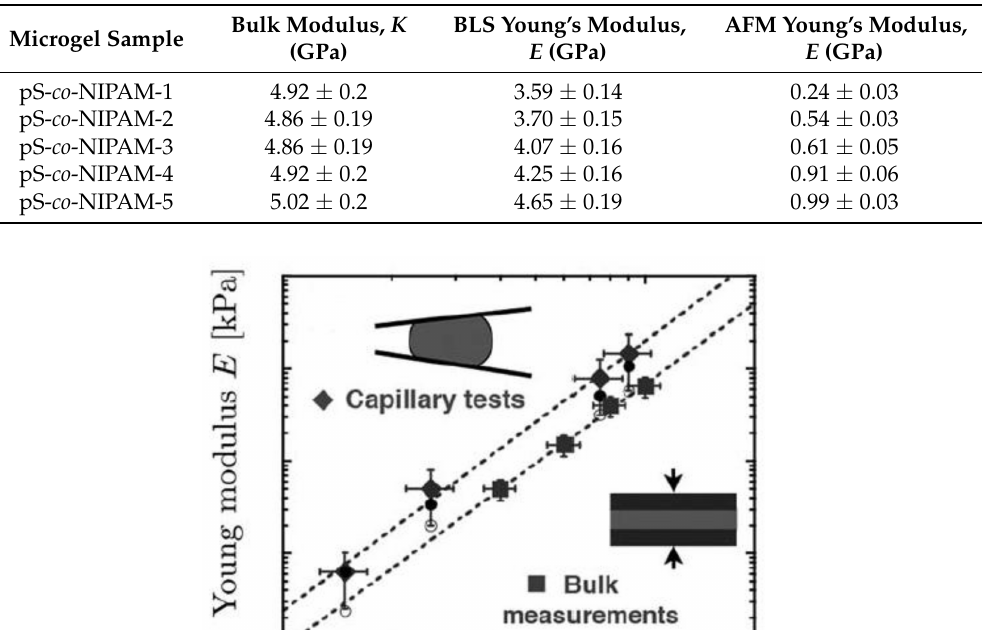
Comparison of Young modulus determined for the air-dried polystyrene-co-poly( n - isopropylacrylamide) (pS- co -NIPAM) microgel series with different cross-link concentration (represented by numbers following the name) using Brillouin light scattering (BLA) and AFM.